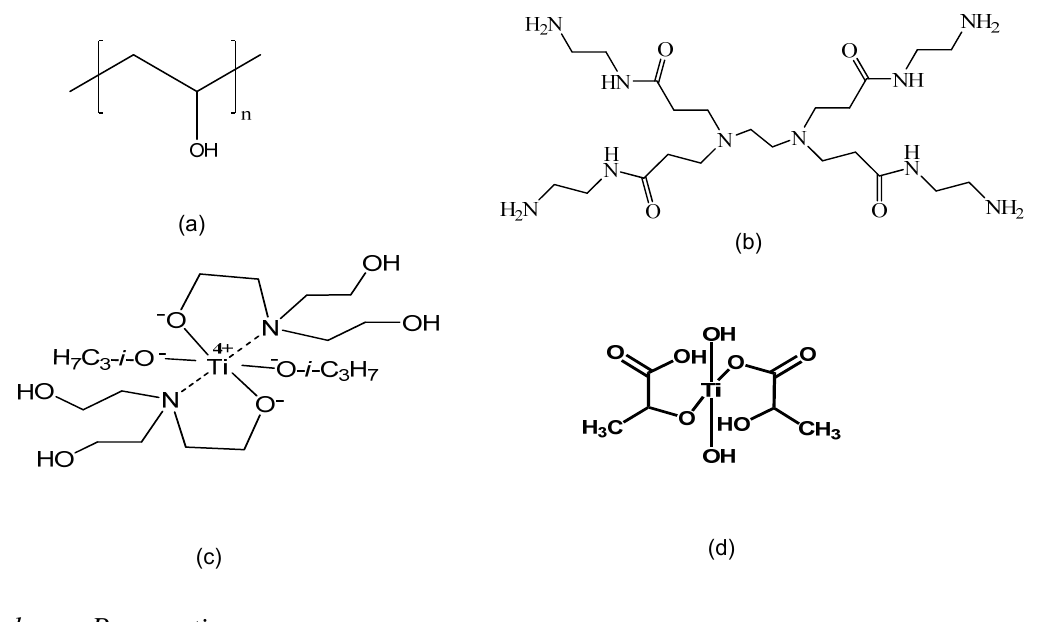
Figure 1. Chemical structures of PVA, PAMAM dendrimer, and Ti cross-linkers. ( a ) Poly(vinyl alcohol) (PVA) ( n = ~2000, M : 88,000); ( b ) Polyamidoamine (PAMAM) W dendrimer ( G = 0, M : 516.7); ( c ) TC-400 cross-linker (di-isopropoxy-bis(triethanol W : 462.4); ( d ) TC-310 cross-linker (di-hydroxy-bis(hydroxypropionic aminato)titanium, M W acid)titanate, M : W